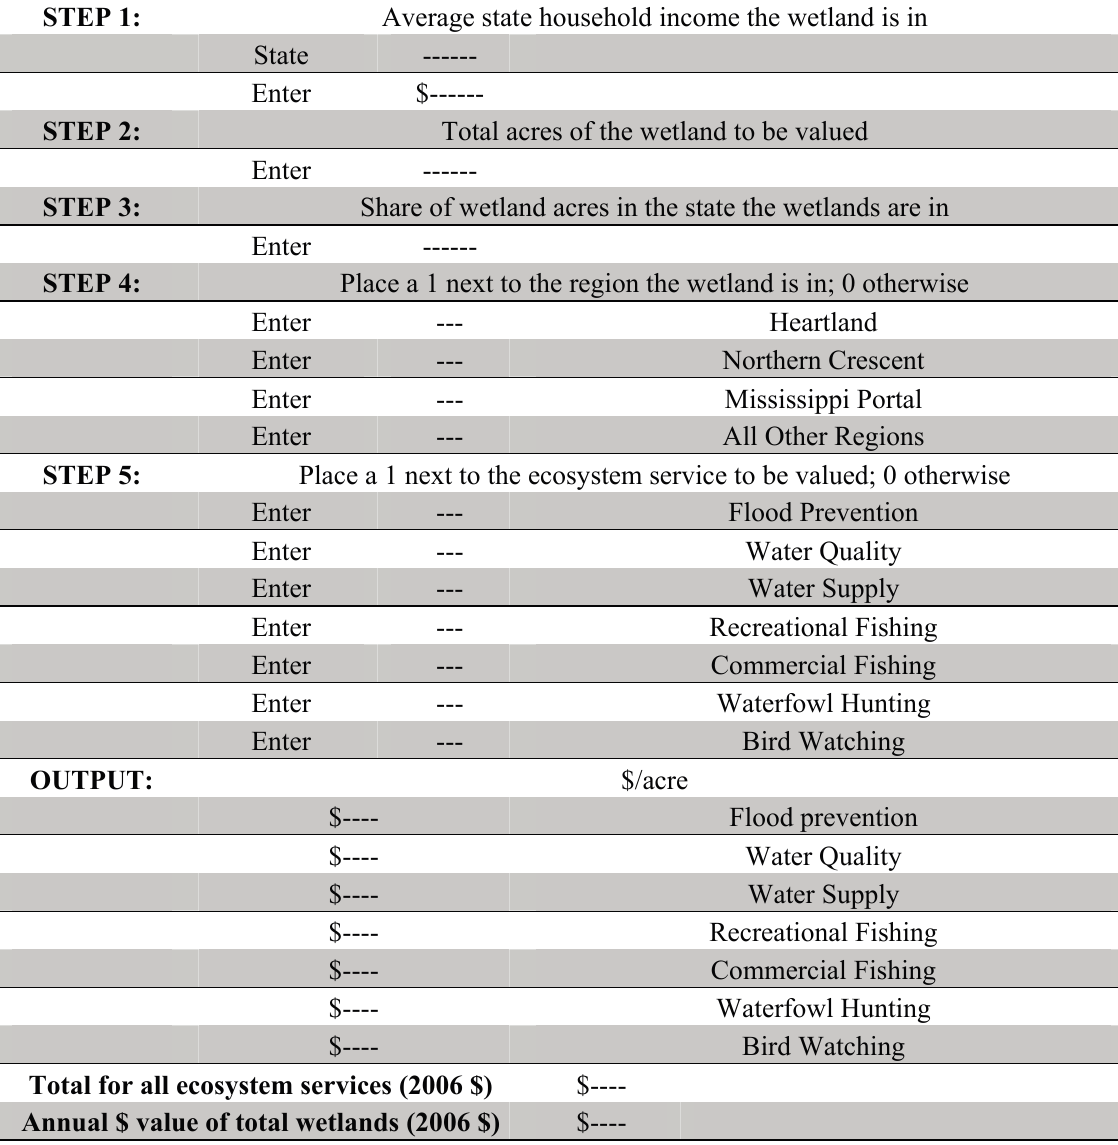
Table 2. Preprogrammed input sheet for valuing total economic value of wetlands a